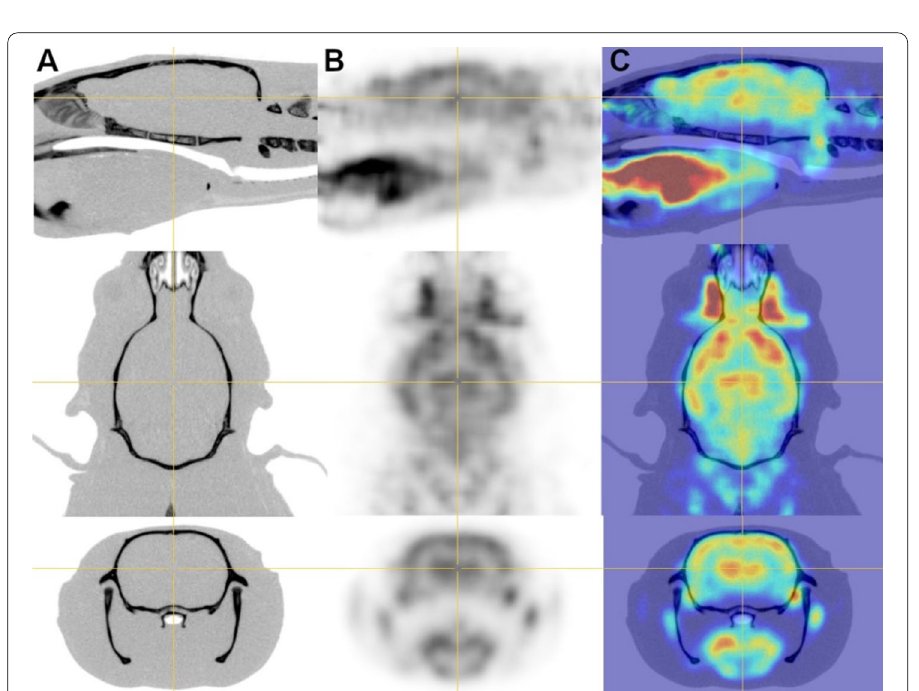
Fig. 5 Coronal, sagittal, and axial slices of (column A) the CT, (column B) the PET and (column C) the co‑registered PET/CT images of the 18 F‑FDG rat’s brain